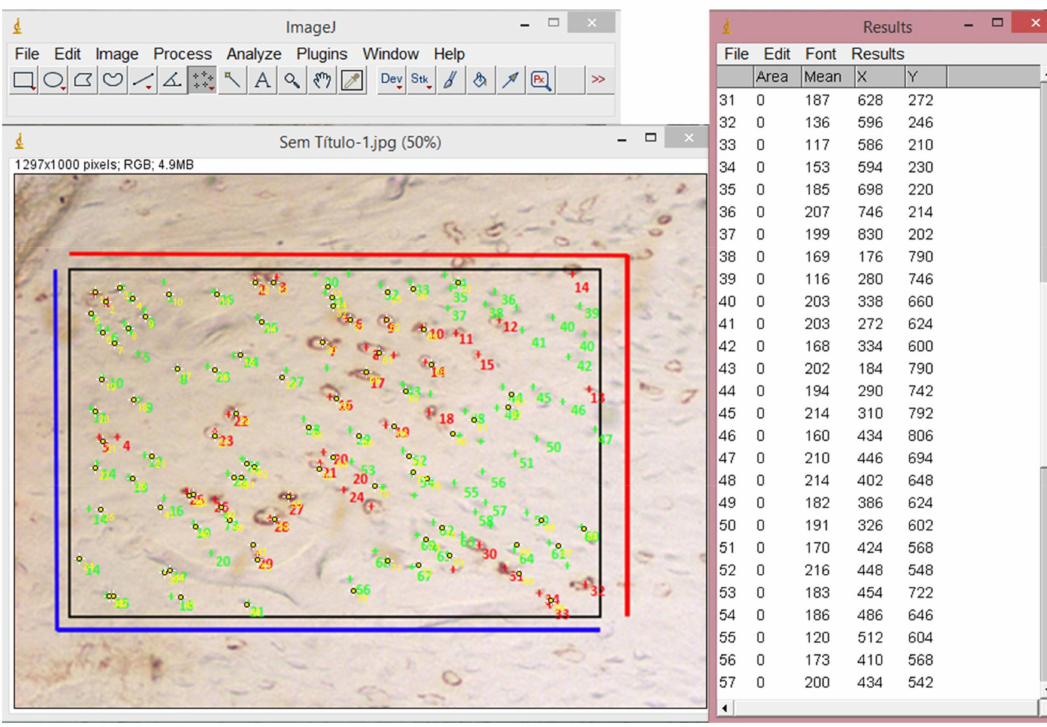
Figure 2. Image of a previously standardized area was included in the captured image to quantify the labeled (in red) and unlabeled (in green) cells using the software ImageJ. Labeled and unlabeled cells were counted 3 times by 2 different researchers (Marcos B. Salles and Sergio A. Gehrke). Since no significative differences were found among the three positions tested for NF- κ B levels (Periostal, Media, and Endostal), data was presented as the mean number of these three positions. NF- κ B quantification was then analyzed at different positions from the site of perforation: location of the perforation (p0), 1 mm from perforation (p1), 4 mm from perforation (p4), 8 mm from perforation (p8) and knee (pk). Positions and regions of interest used for cell analysis in each sample are indicated in the scheme in Figure 3.